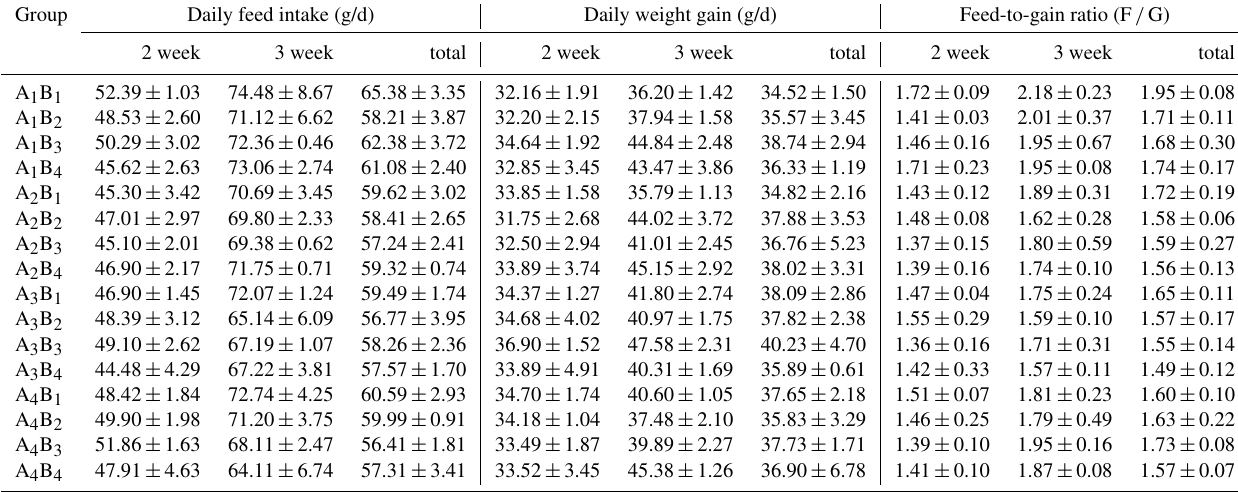
Table 2. The growth performance of Arbor Acres broilers under low temperature conditions supplemented by glutamine and L-carnitine. Group Daily feed intake (g/d)